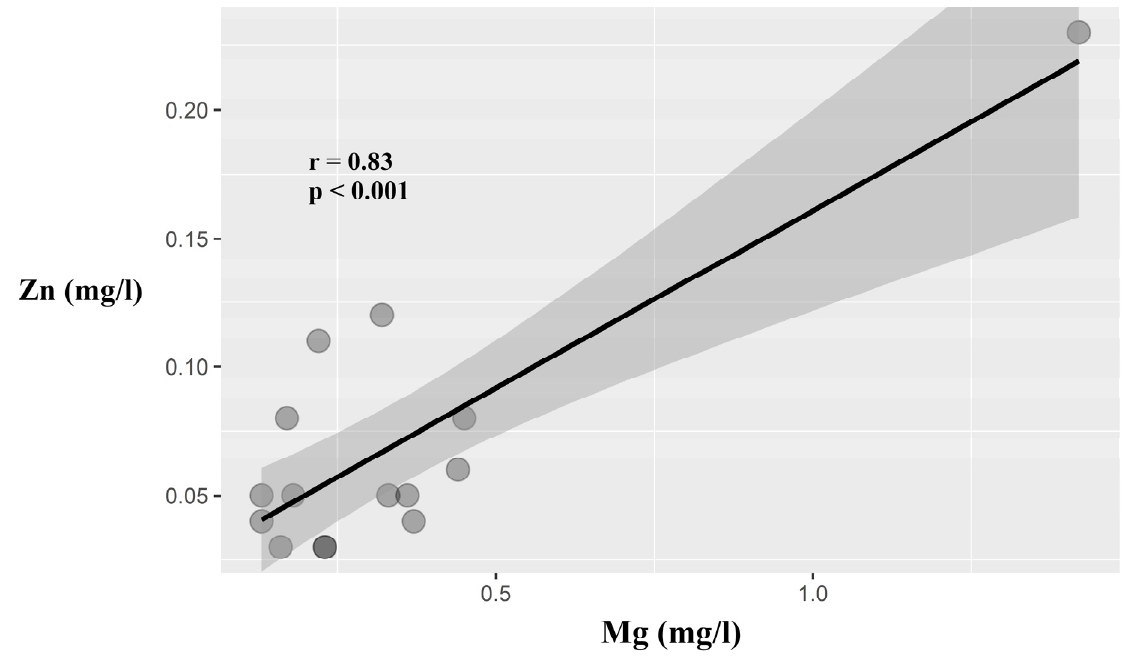
Figure 3. Scatter plot of correlation between Mg and Zn in sixth enamel layer.